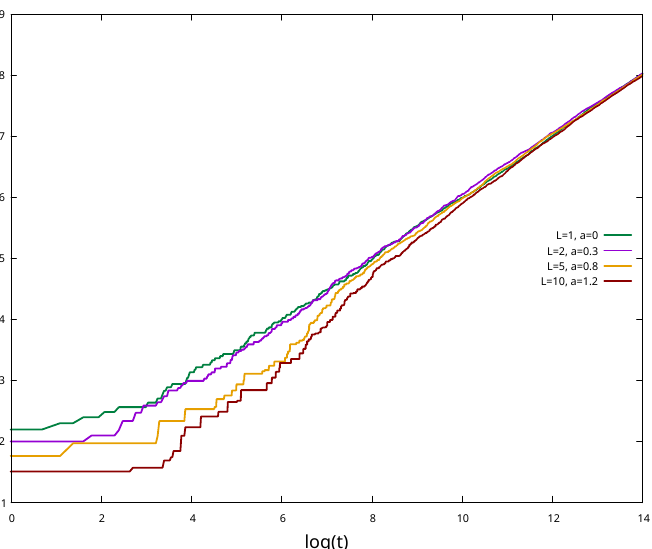
Figure 5. Logarithmic plot of knowledge corpus c for N = 10,000 and K = 4. It is possible to numerically rescale the function with different L to obtain an asymptotic convergence. The same results could be obtained by varying K